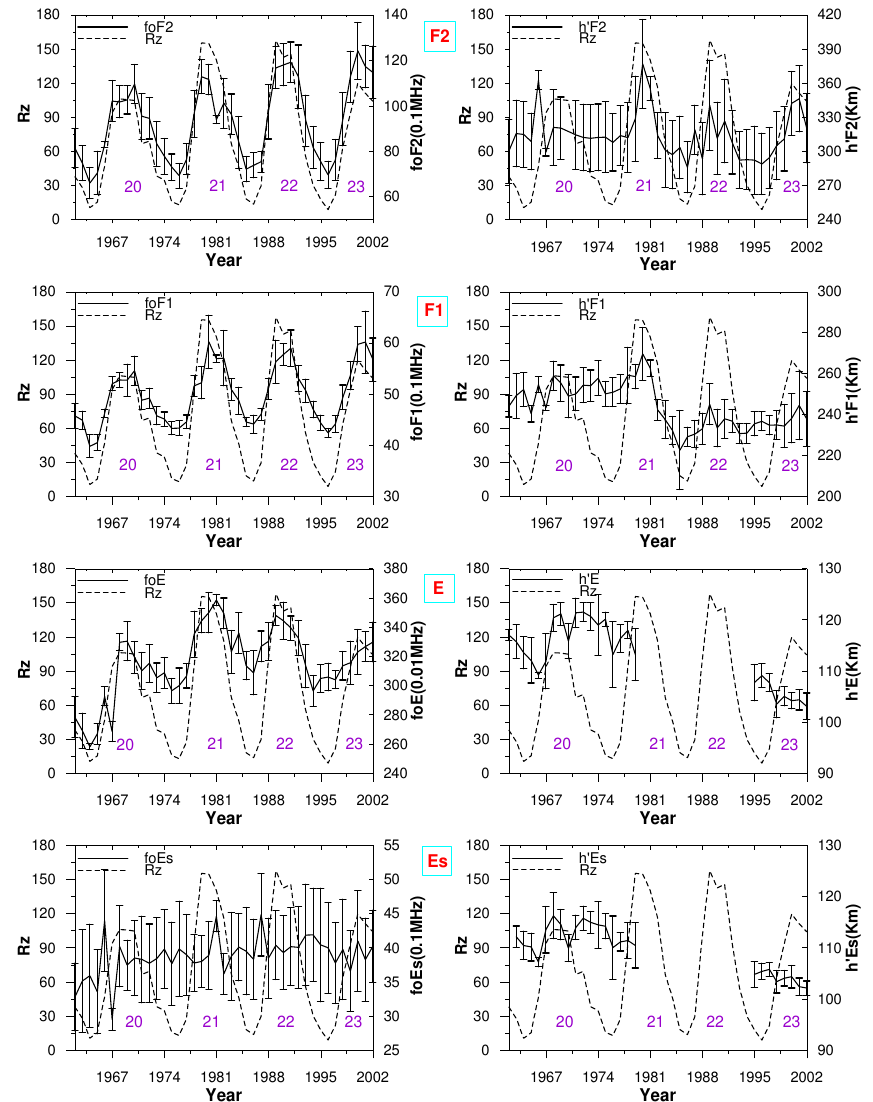
Fig. 1. Yearly variation of critical frequencies (left side) and virtual heights (right side) of the F2, F1, E and Es layers (solid line) and sunspot number (dashed line) during solar cycles 20, 21 and